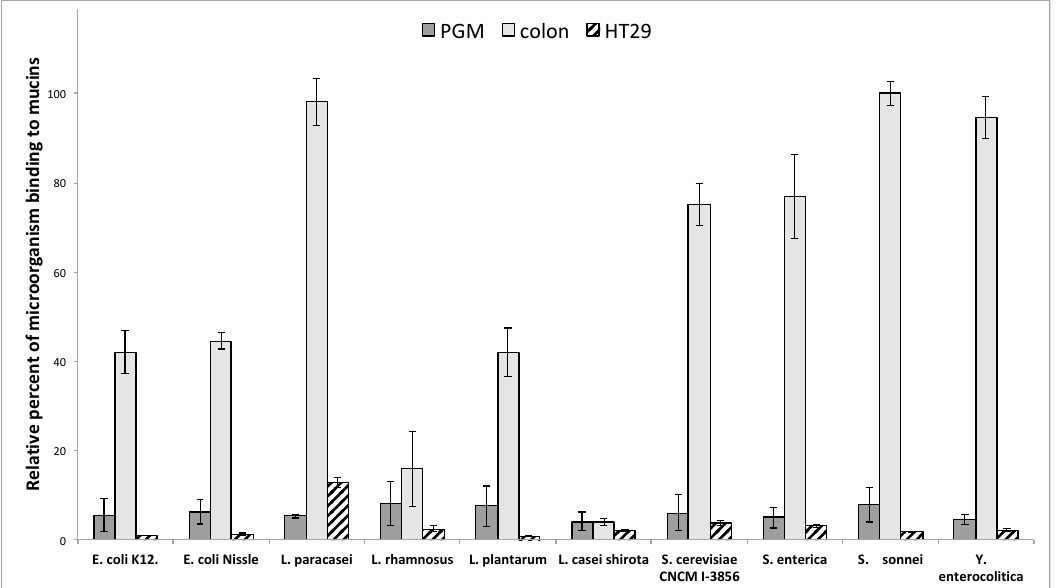
Figure 3. The adhesion of various probiotic and pathogenic microorganisms on commercially available pig gastric mucins or mucins from HT29-MTX cell lines does not reflect the adhesion on human intestinal mucins. The binding of DAPI-labeled microorganisms to pig gastric mucins (dark grey), human purified colonic mucins (light grey) and mucins from HT29-MTX (striped) was quantified by slot-blot overlay assays. No correlation was observed between the level of adhesion of microorganisms to colonic mucins and to HT29-MTX or PGM. Data shown is a representative experiment ± SD of three replicates.